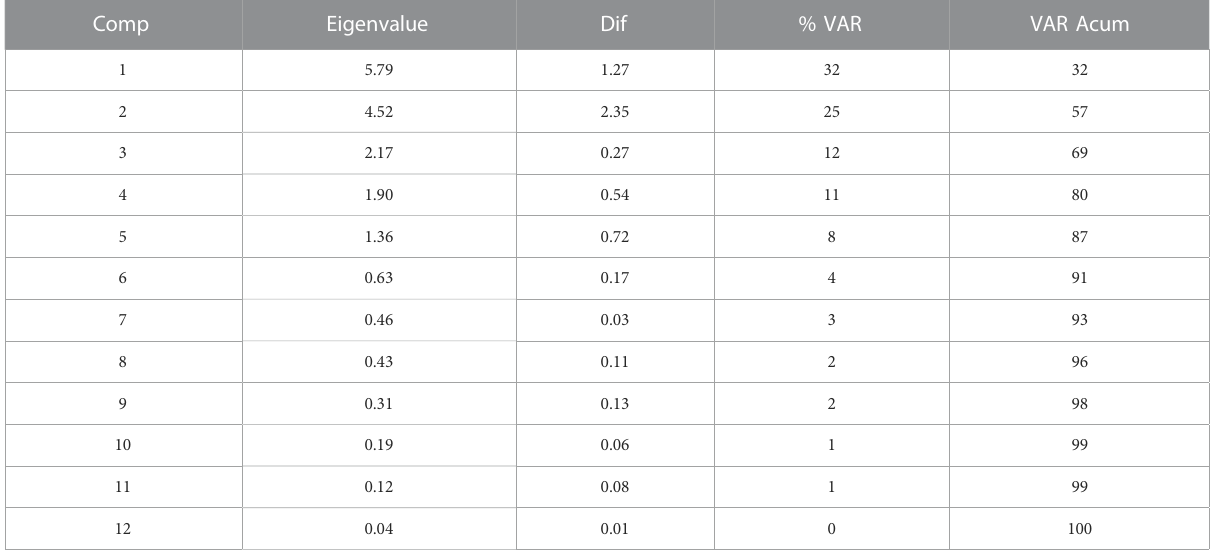
TABLE 9 Eigenvalues and explained variances for components of PCA.